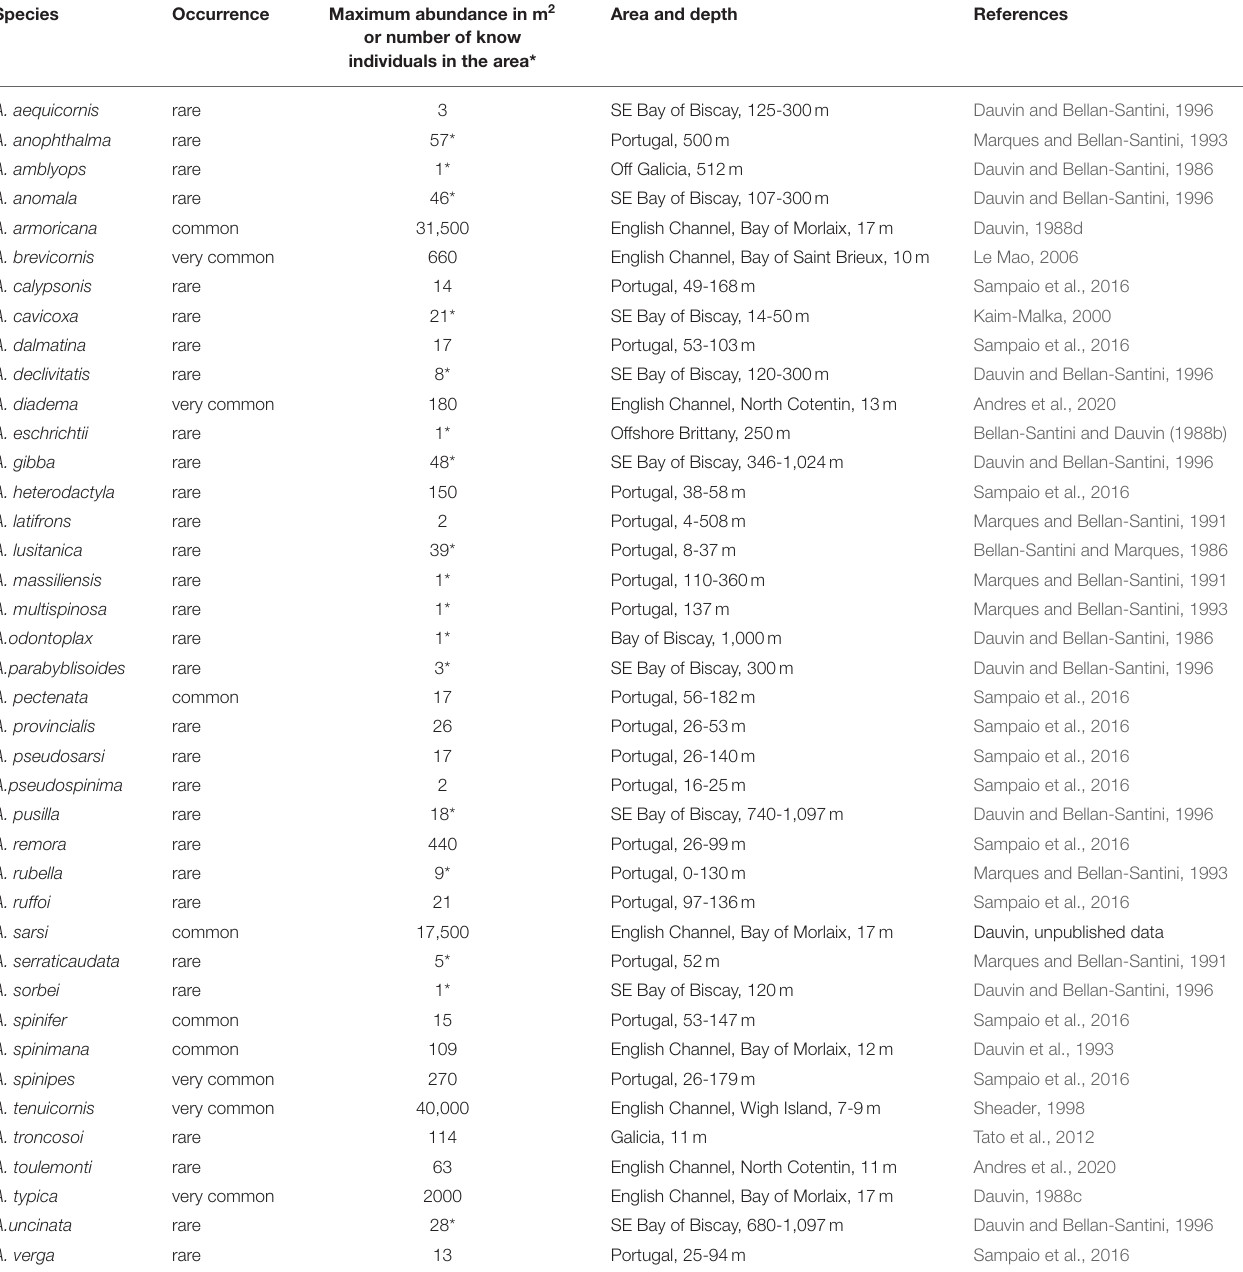
TABLE 2 | Ampelisca occurrence of the species classified in three categories: rare, few records; common: numeroux records, and very common species in most of the shallow soft-bottom communities.